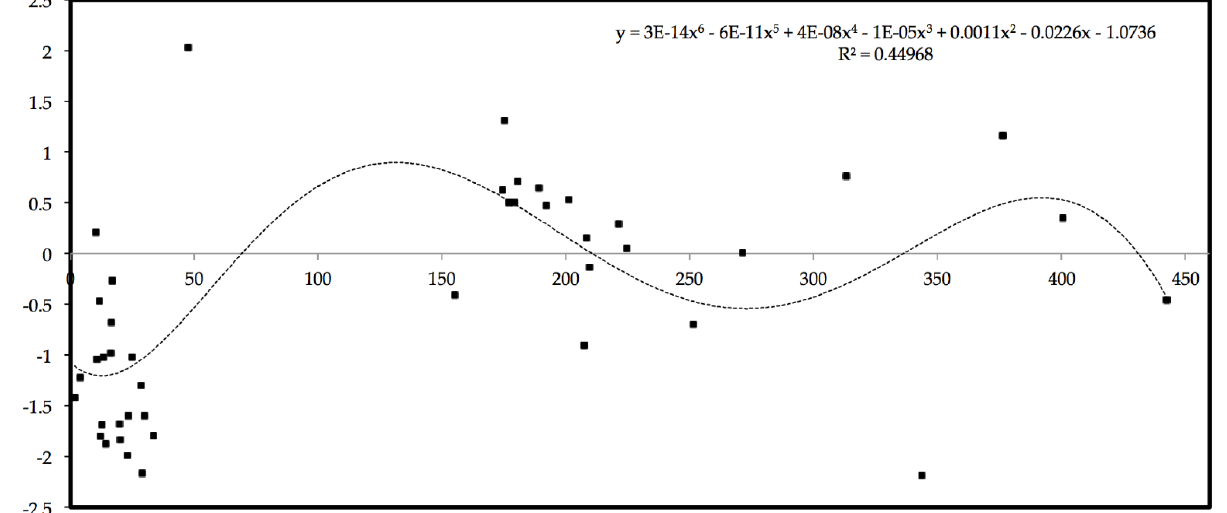
Figure 6. Graphical distribution of the overall standardized residuals, trendline, and R 2 values. x axis — b in Ws 1/2 m −2 K; y axis — entropy in J/K.